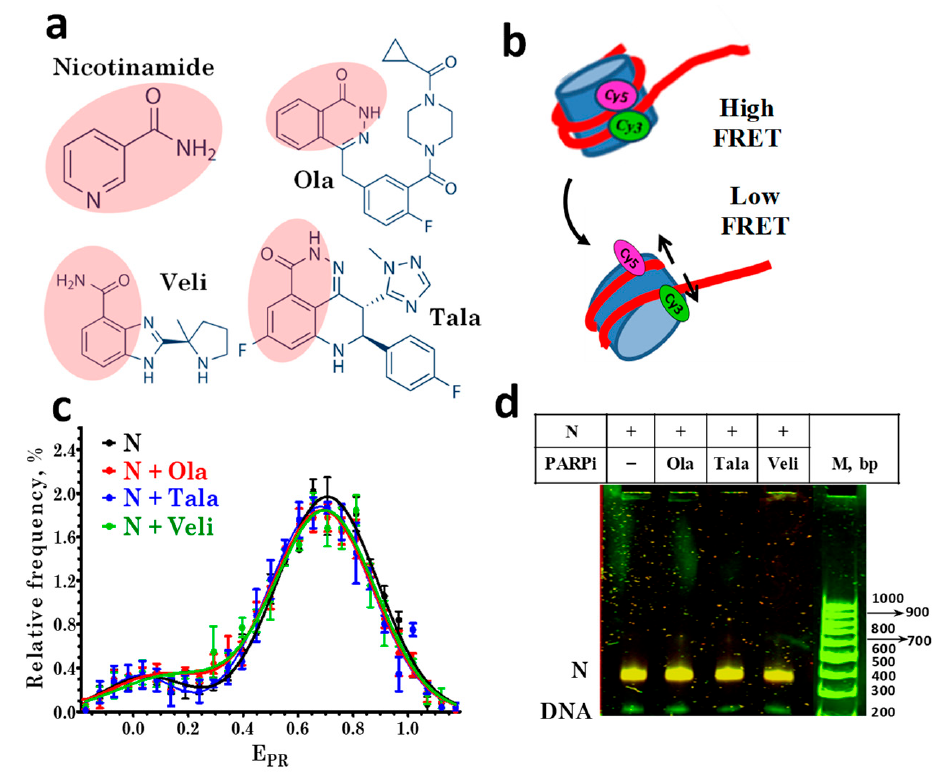
Figure 1. PARP1 inhibitors do not affect the nucleosome structure. ( a ) Structures of nicotinamide and the studied PARPi: olaparib (Ola), talazoparib (Tala), and veliparib (Veli). Pink shading indicates the nicotinamide pharmacophore in the PARPi structures. ( b ) Changes in FRET efficiency induced by alterations in the nucleosome structure. In intact nucleosomes, FRET efficiency is high due to the proximity of Cy3 and Cy5 localized on adjacent DNA gyres. If the nucleosome structure changes are accompanied by an increase in the distance between labels, the efficiency of FRET decreases. ( c ) E PR profiles of nucleosomes in the absence and presence of 10 µ M PARPi. N-nucleosomes. E PR profiles are presented as the mean ± standard error of the mean ( n = 3). ( d ) EMSA data for nucleosomes (N) in the absence and presence of 10 µ M PARPi: analysis of FRET in gel. The color scheme used to distinguish different FRET efficiencies for nucleosomes in gel was as follows. FRET efficiency decreases in the order: orange> yellow > green color. The same yellow color of the nucleosome bands indicates the absence of structural changes in nucleosomes caused by PARPi.